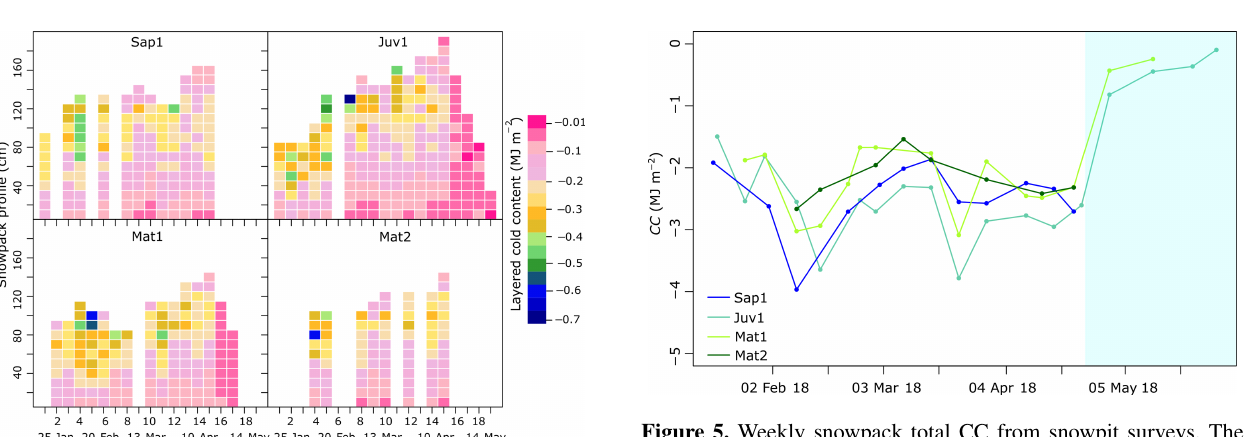
Figure 5. Weekly snowpack total CC from snowpit surveys. The light blue shading represents active spring